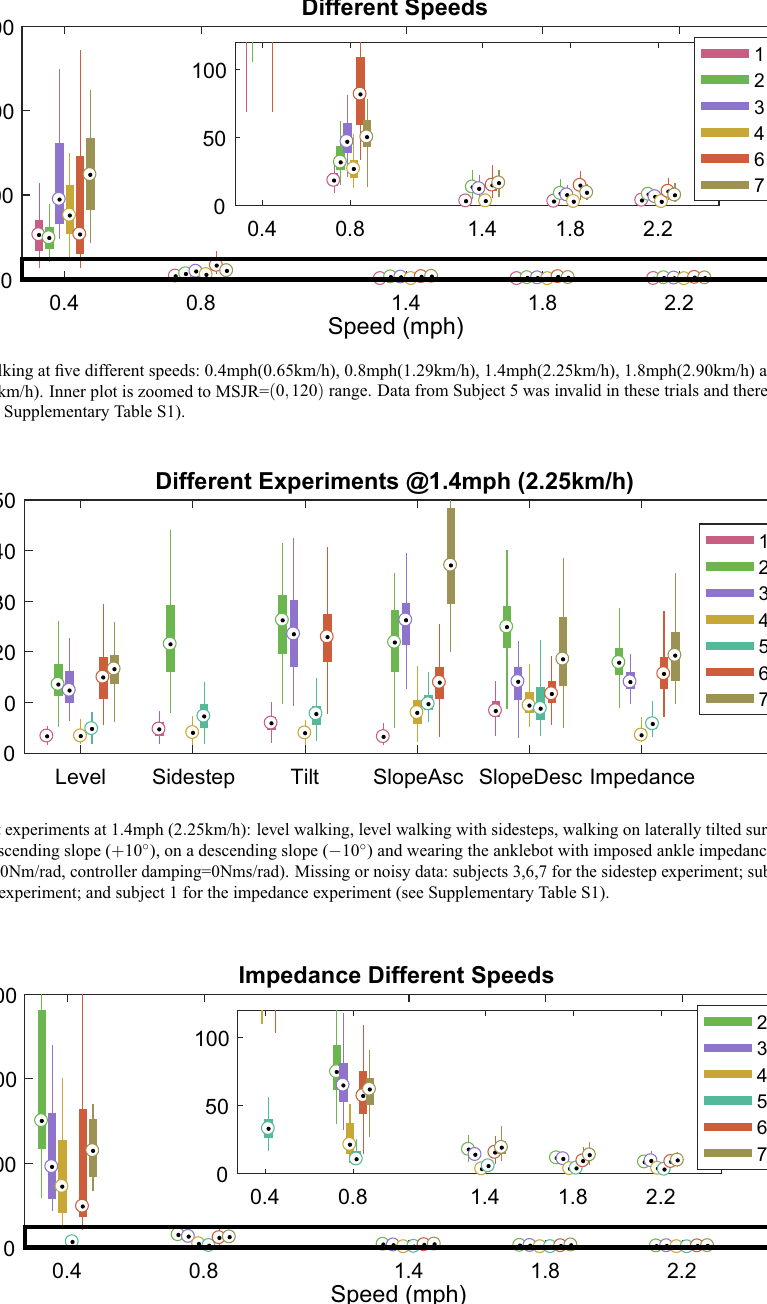
In order to explain the range of MSJR values found at the different speeds, the step amplitude and the ratio between swing time and stride period were computed for all strides of every subject in level walking at different speeds (Fig. 3). Swing time is computed from the forward position as the time between a negative peak and the following positive peak. The difference in forward position between these two points is the step amplitude. The period is computed as described in “Methods” for the sine wave period. The stride swing/period ratio (Fig. 3a)